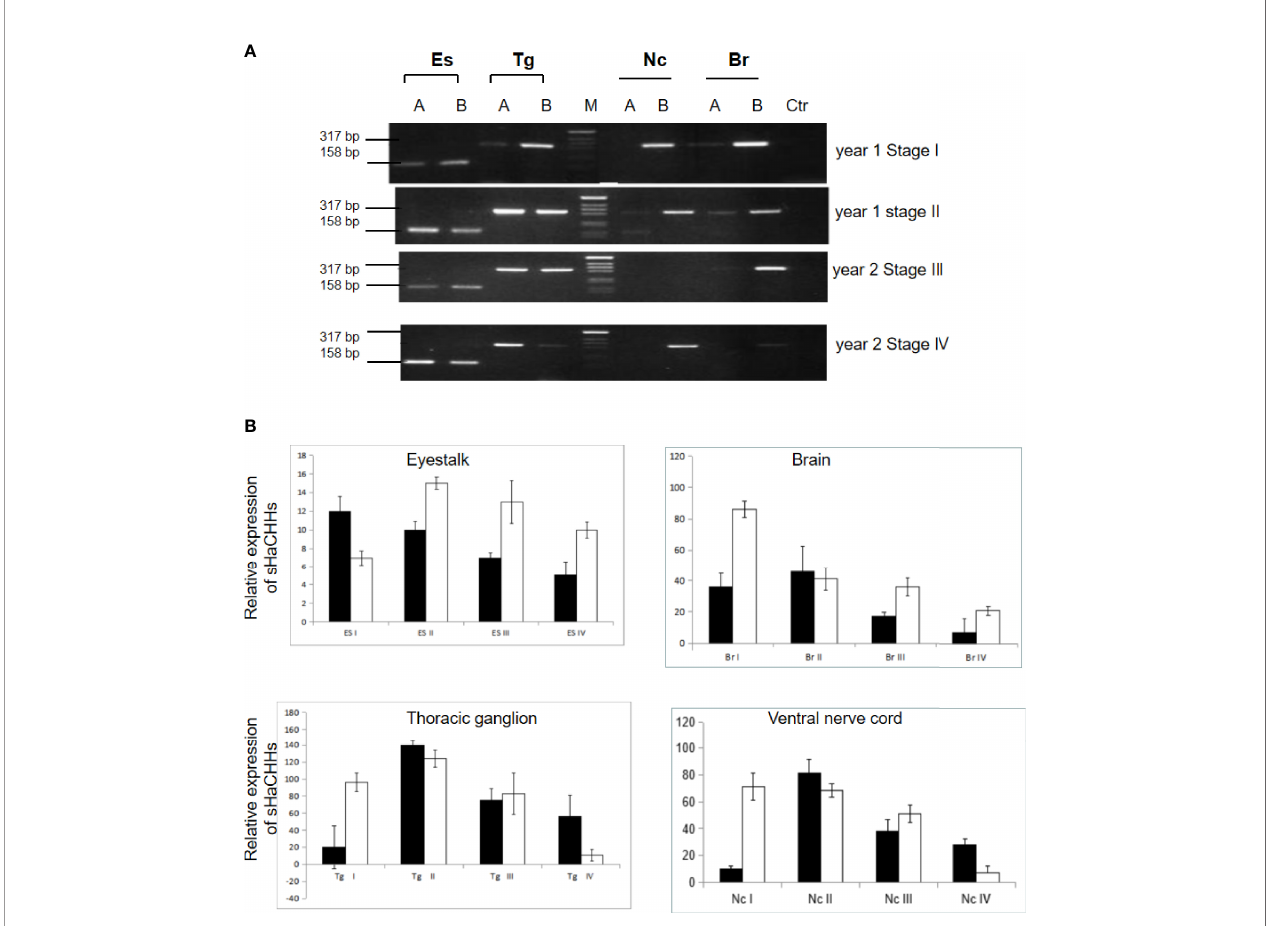
FIGURE 7 | Expression study of sHaCHH-A and sHaCHH-B by Semi-quantitative (A) and (B) qPCR. (A) Agarose gel analysis of the PCR products and detection of the sHaCHH-A, HaCHH-A sHaCHH-B, HaCHH-B. The lanes A used primers for HaCHH-A gene and lane B used primers for HaCHH-B forcDNA from eyestalk (Es), thoracic ganglion (Tg), ventral nerve cord (Nc) and brain